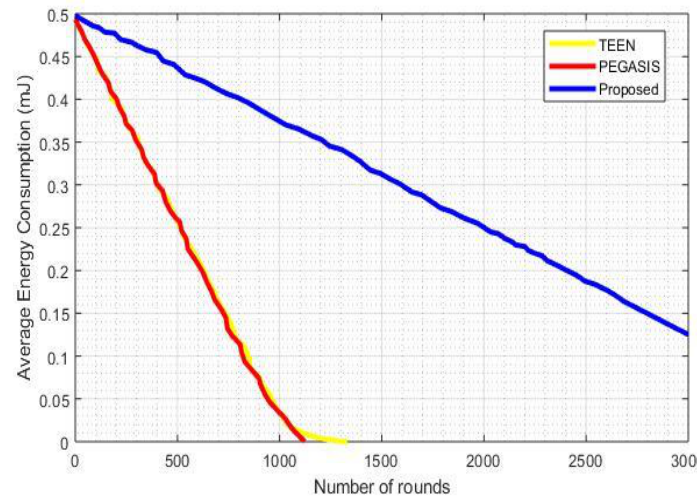
Figure 7. Energy consumption with 150 nodes.